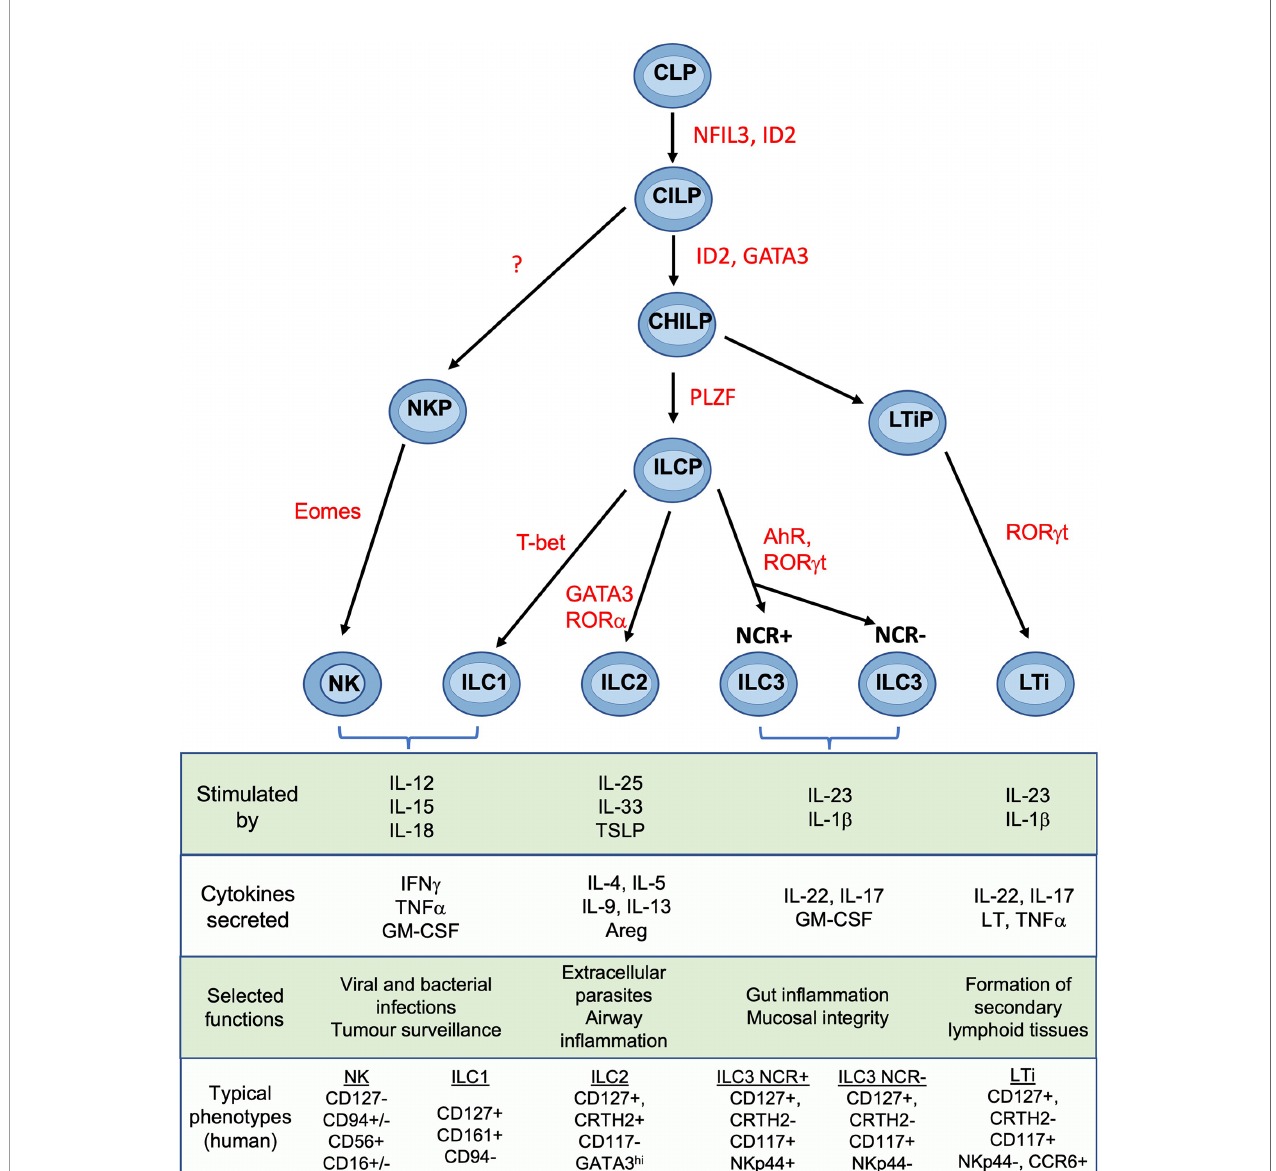
FIGURE 2 | Development and functions of NK cells and ILCs Simpli fi ed overview of key stages of ILC development. Scheme shown is largely based on murine data. Table shows typical cytokines that stimulate the main ILC subsets, together with their principal effector molecules and known immune functions. Phenotypic markers commonly used to identify human subsets are shown and assumes prior gating on lin-CD45+ cells. CLP common lymphoid progenitor, CILP, common innate lymphoid progenitor; CHILP, common helper ILP; ILCP, innate lymphoid cell precursor; NKP, NK progenitor; LTiP, lymphoid tissue inducer precursor; LTi, lymphoid tissue inducer; NFIL3, Nuclear factor, interleukin-3 regulated; ID2, inhibitor of DNA binding 2; GATA3, GATA binding protein 3; PLZF, promyelocytic leukemia zinc fi nger; T-bet, T-box transcription factor 21; Eomes, eomesodermin; AhR, aryl hydrocarbon receptor; ROR, Retinoic acid – related orphan receptor; TSLP, thymic stroma lymphopoietin; Areg, amphiregulin; LT, lymphotoxin; IFNg, interferon-gamma; IL, interleukin; NCR, natural cytotoxicity receptor; NK, natural killer. Figure and phenotypic markers adapted from Vivier et al. (18) and Guia and Mancinelli